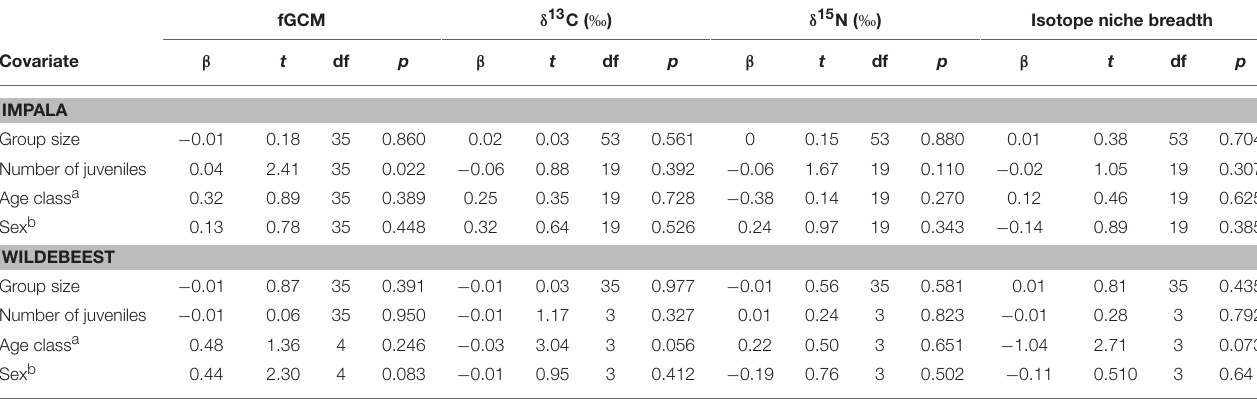
TABLE 2 | Estimated effects of covariates related to group (group size, number of juveniles) and individual (age, sex) characteristics on fecal glucocorticoid metabolite (fGCM) concentrations, δ 13 C, δ 15 N, and isotope niche breadth in impala and wildebeest.